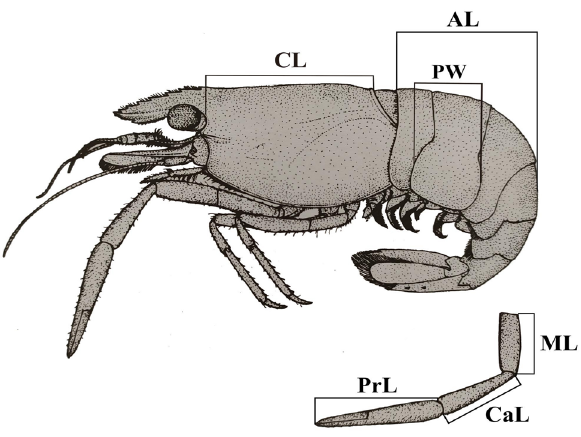
Figure 2. Macrobrachium candango Mantelatto, Pileggi, Pantaleão, Magalhães, Villalobos and Álvarez, 2021. Structures used in morphometric analyses: (CL) carapace length; (AL) abdomen length; (PW) pleura width; (ML) merus length; (CaL) carpus length; (PrL) propodus length. Adapted from Melo